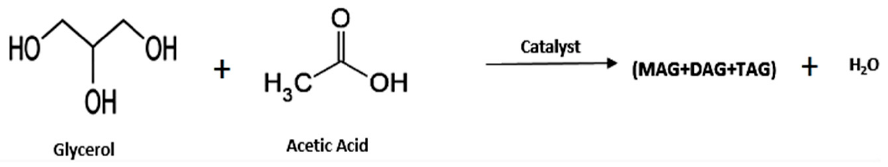
Scheme 1. Conversion of glycerol to acetin using carboxylic acids like acetic